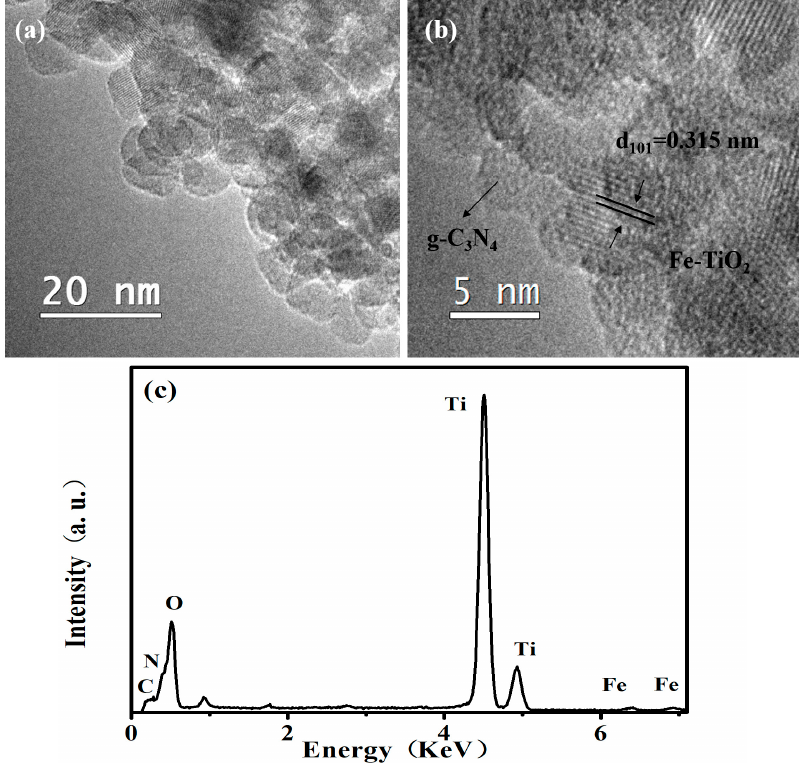
Figure 3. TEM ( a , b ) and EDX; ( c ) images of 0.05Fe ‐ CT.